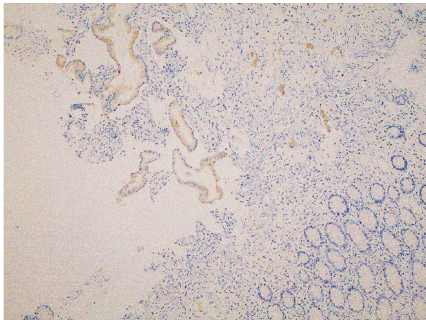
Figure 2: Immunohistochemical (IHC) staining of rectal biopsy taken during colonoscopy. Positive staining was detected in tumoral glandular structures by immunohistochemical examination of CK7.